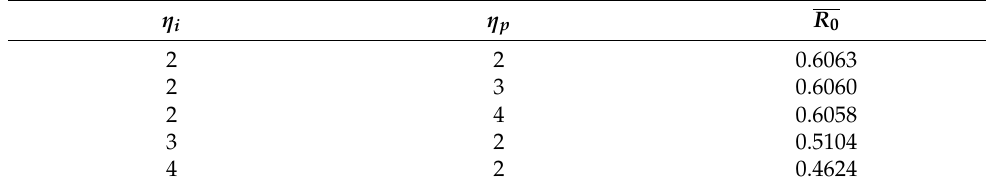
Table 2. Dependence of the reproduction number on parameters of the integral terms. η i η p R